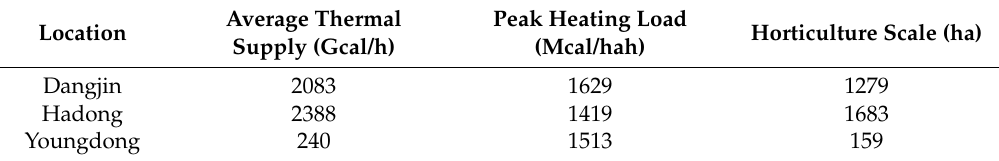
Table 6. Potential size of horticulture